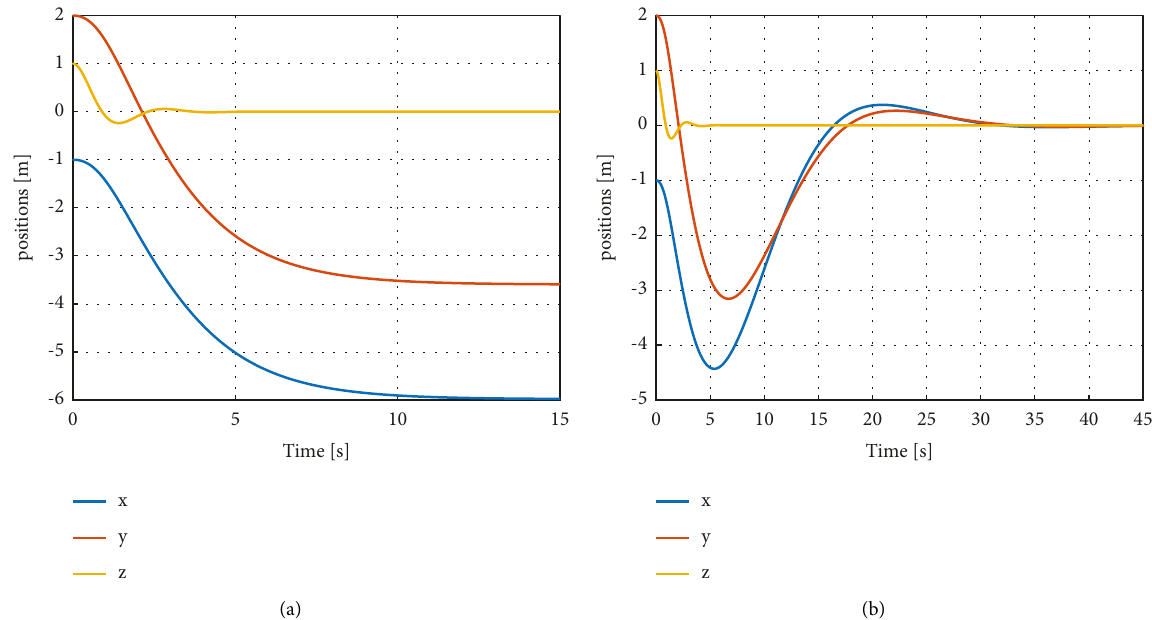
Figure 19: The position variables x , y , and z stabilize to zero after 45s; the x and y states experience overshoots before stabilizing to